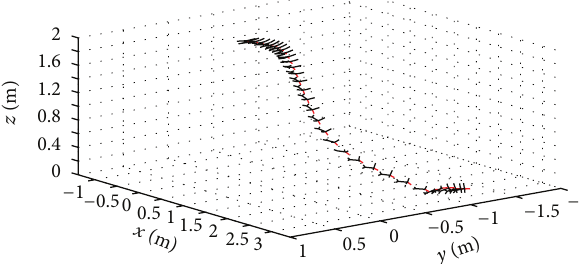
Figure 6: Flight test results for articulated MAV during gliding